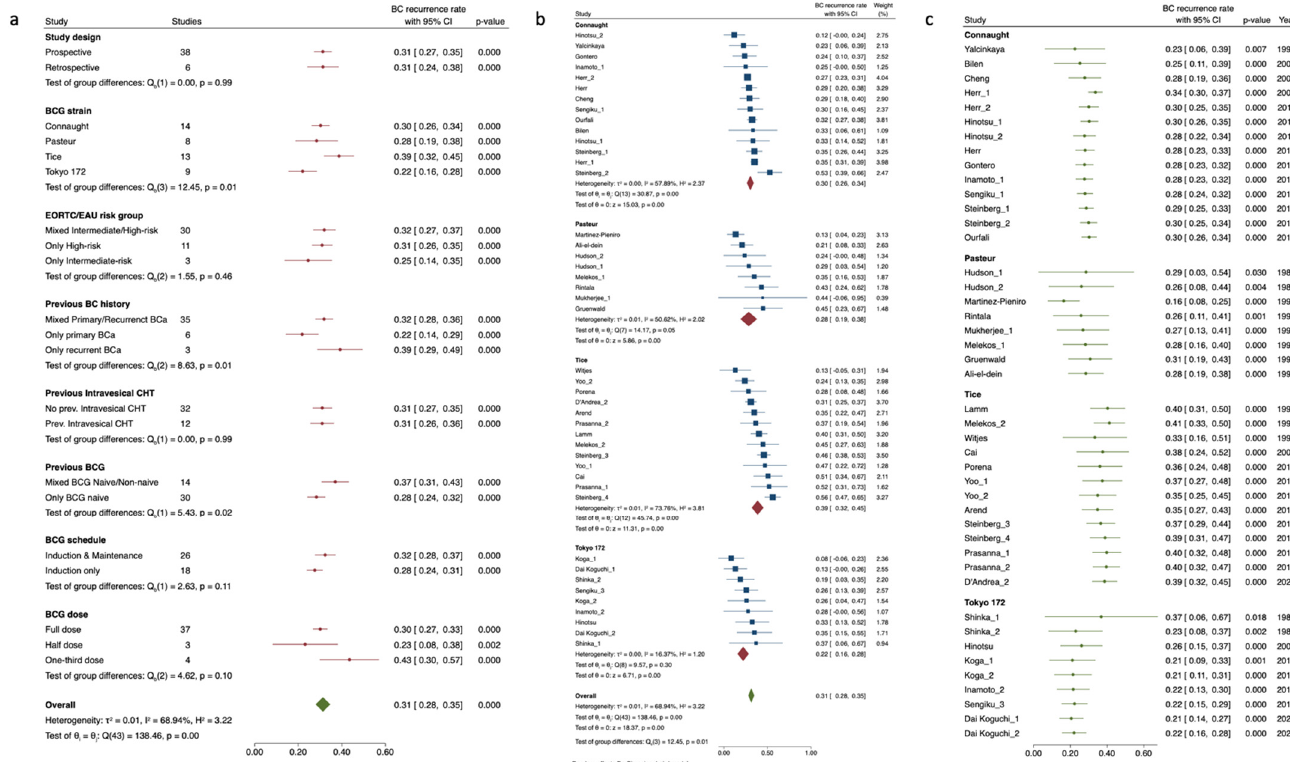
Figure 1. Sub-groups analysis for BC recurrence rate by studies with ≤ 3-y RFS endpoints exploring heterogeneity according to categorical confounders (e.g., study, BCG, and NMIBC characteristics) ( a ). Forrest plot depicting BC recurrence rate by studies with ≤ 3-y RFS endpoints grouped by BCG strains and sorted by increasing effect size ( b ). Forrest-plot for cumulative meta-analysis by studies with ≤ 3-y RFS endpoints grouped according to BCG strain and sorted by year of publication ( c ). BC: Bladder Cancer; BCG: Bacillus Calmette–Guérin; Bladder Cancer; CHT: Chemotherapy; EAU: European Association of Urology.